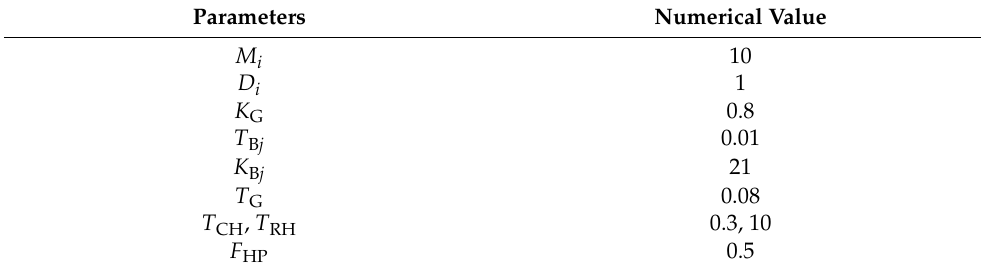
Table 4. System simulation